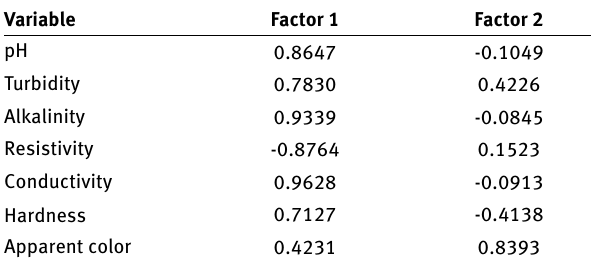
Table 2: Loadings of the samples in relation to the direction of the main components (Factor 1 and 2) for the water types